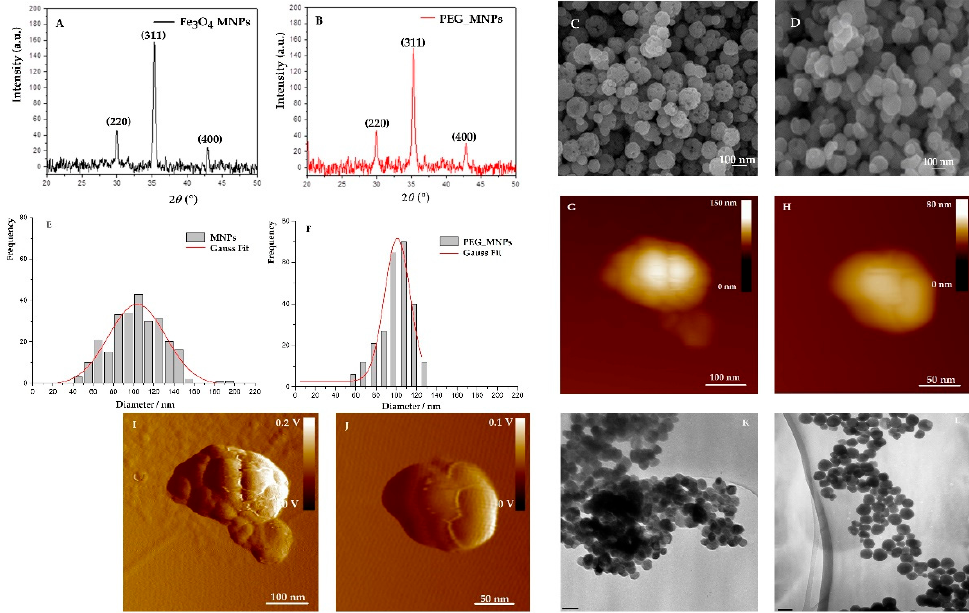
Figure 3. XRD pattern of ( A ) mesoporous bare MNPs Fe3O4; ( B ) PEG-coated MNPs; SEM images of ( C ) bare Fe3O4 MNPs showing the rough rounded cluster with extensive open porosity ranging from 30 to 200 nm in diameter; ( D ) SEM image of the surface of PEG-coated Fe3O4 MNPs ranging in di-ameter from 50–130 nm; Histogram of bare MNPs Fe3O4 ( E ) and PEG-coated Fe3O4 MNPs ( F ); (2D height topographic AFM image of single ( E ) bare magnetite Fe3O4 MNPs ( G ) and ( F ) PEG-coated Fe3O4 MNPs ( H ) showing cluster structure details; 2D-amplitude AFM image of single ( G ) bare magnetite ( I ) and ( H ) PEG-coated MNPs ( J ) showing subcluster structures in size range from 10 to 30 nm; TEM images of ( K ) bare Fe3O4 MNPSs; ( L ) TEM image of the surface of PEG-coated Fe3O4 MNPs.